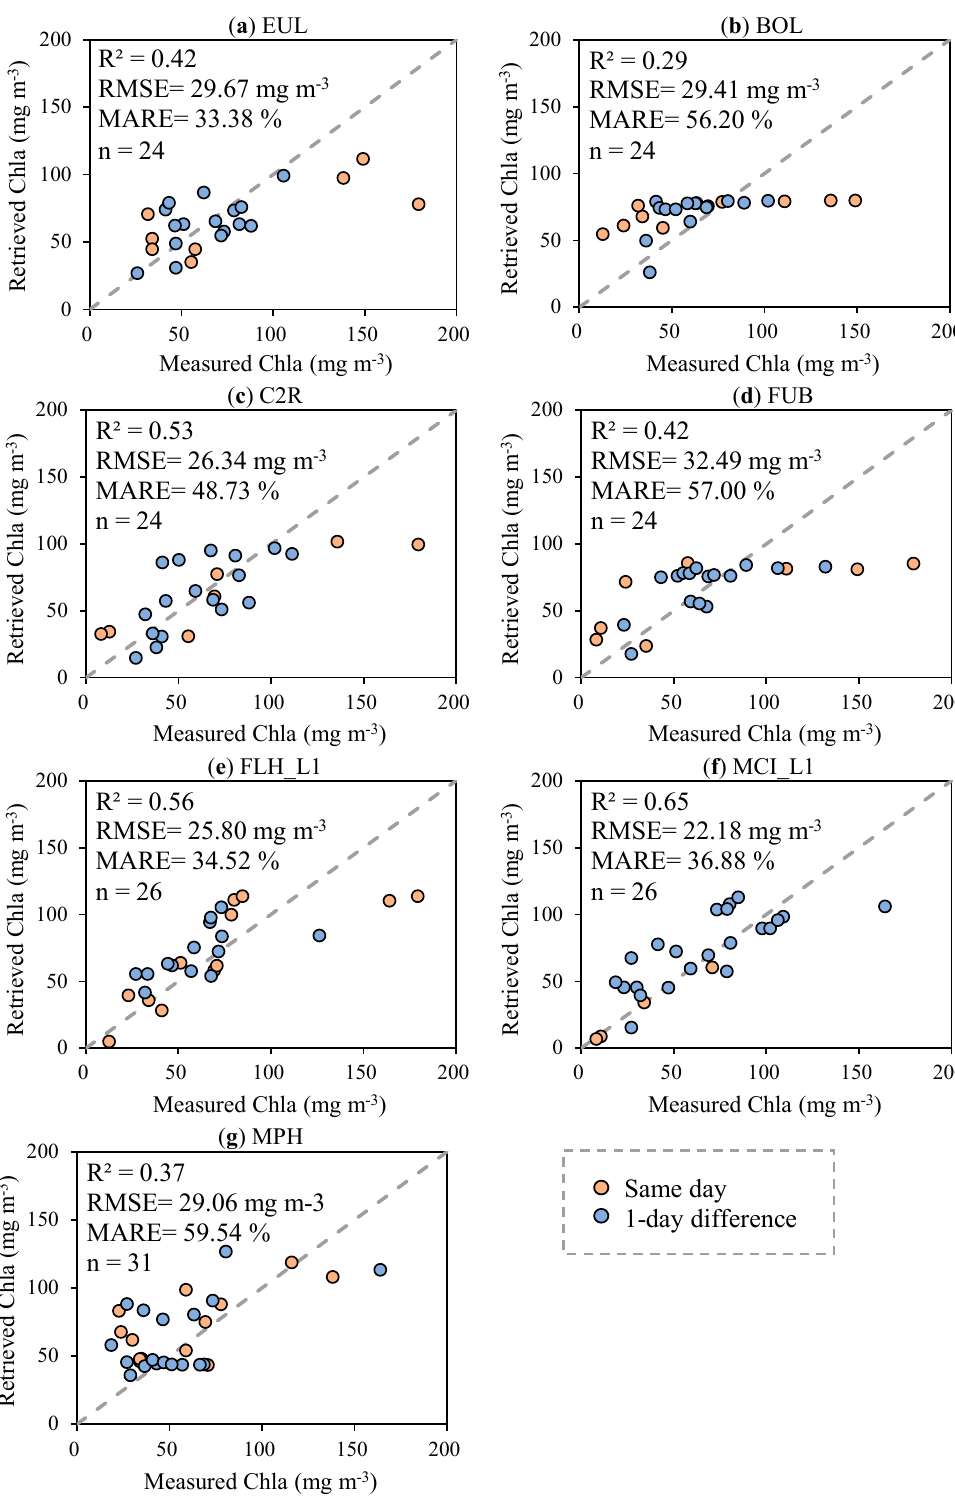
Figure 7. Validation of ( a ) EUL; ( b ) BOL; ( c ) C2R; ( d ) FUB; ( e ) FLH; ( f ) MCI; and ( g ) MPH processors. n denotes the number of samples used during the validation stage ( n represents 30% of total match-ups available for each processor).